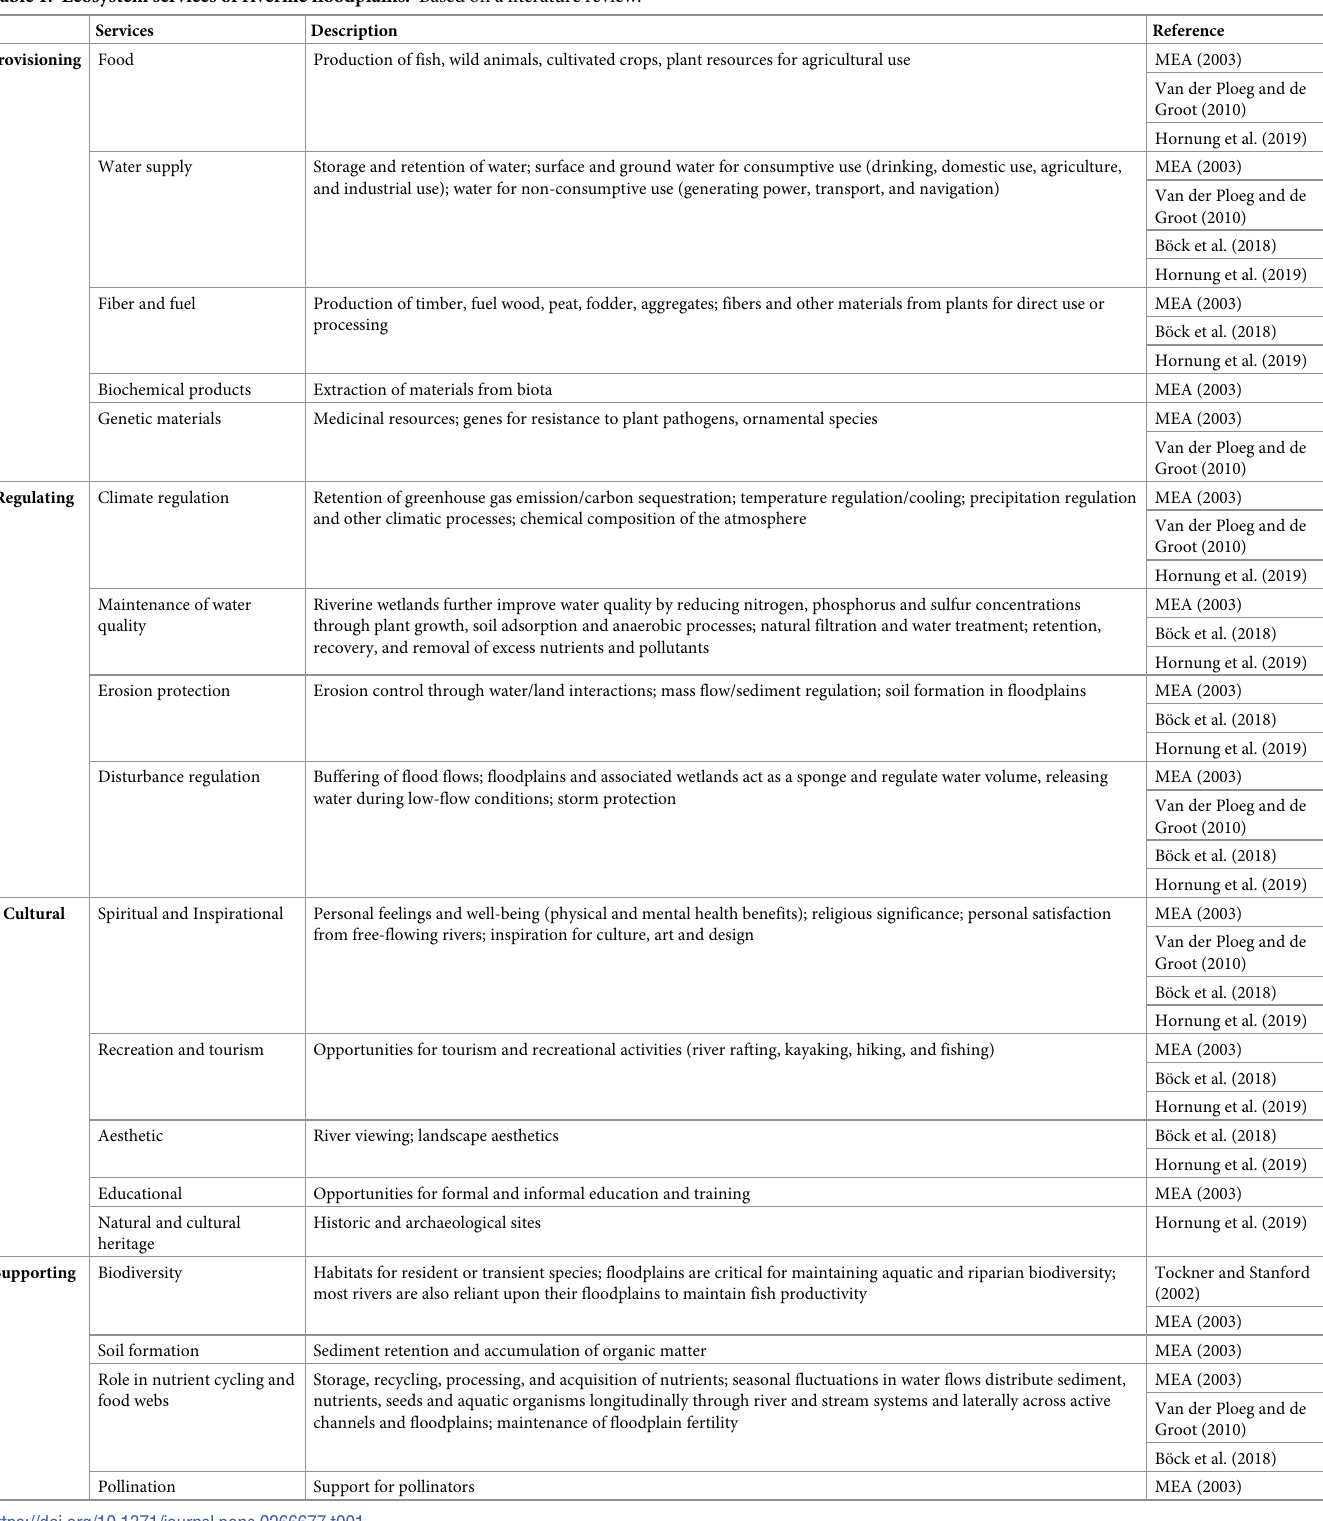
Table 1. Ecosystem services of riverine floodplains. Based on a literature